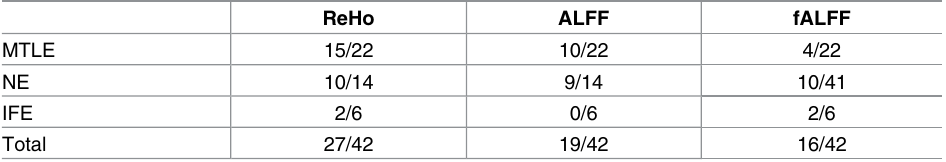
Table 4. EZ localization rates of ReHo, ALFF, and